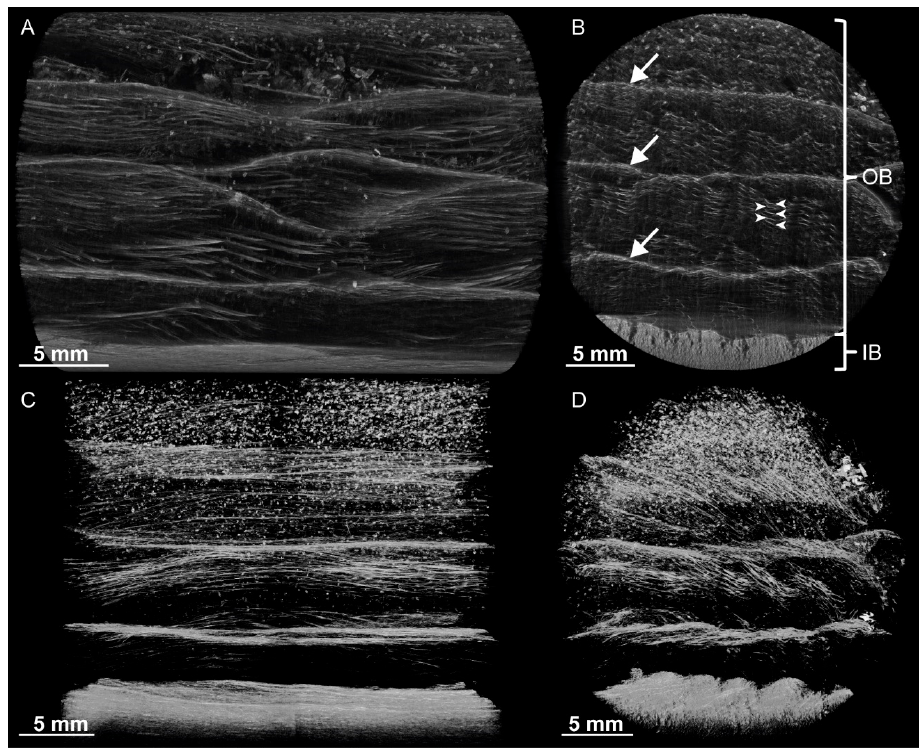
Figure 2. Images of a µCT scan of the bark of S. giganteum . ( A ) Radial section with partly intersecting layers (higher hierarchical level) of the outer bark. ( B ) Cross-section showing partly intersecting layers (higher hierarchical level) of the outer bark (IB = inner bark, OB = outer bark; arrowheads indicate representative layers on the lower hierarchical level, arrows indicate layers on the higher hierarchical level). ( C , D ) Segmentation of the µCT scan gives further insights into the layered structure of the outer bark, visualized by a radial sectional view ( C ) and a cross-sectional view ( D ). A video of the same µ CT scan can be found in the Supplementary